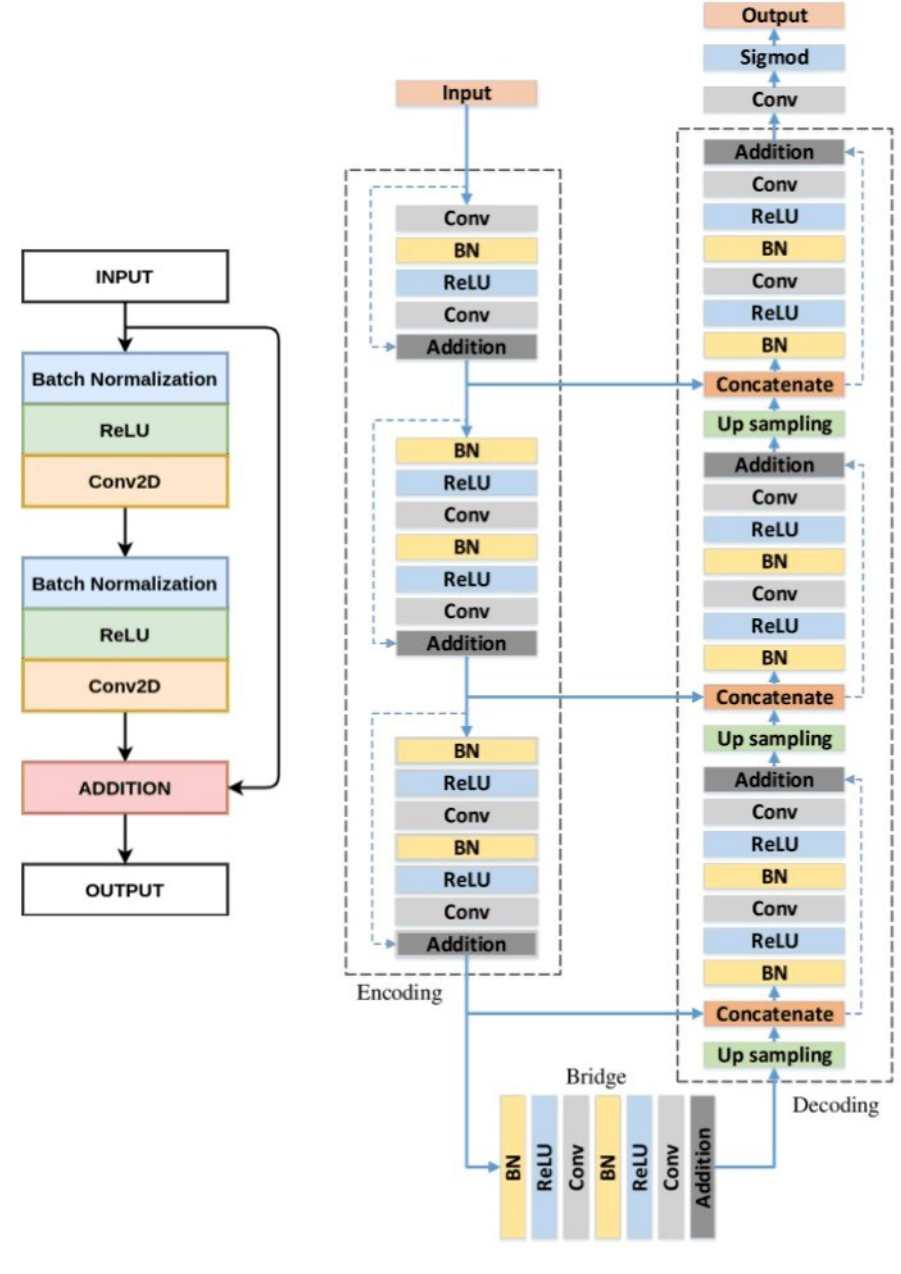
Figure 6. Illustration of ResU-Net